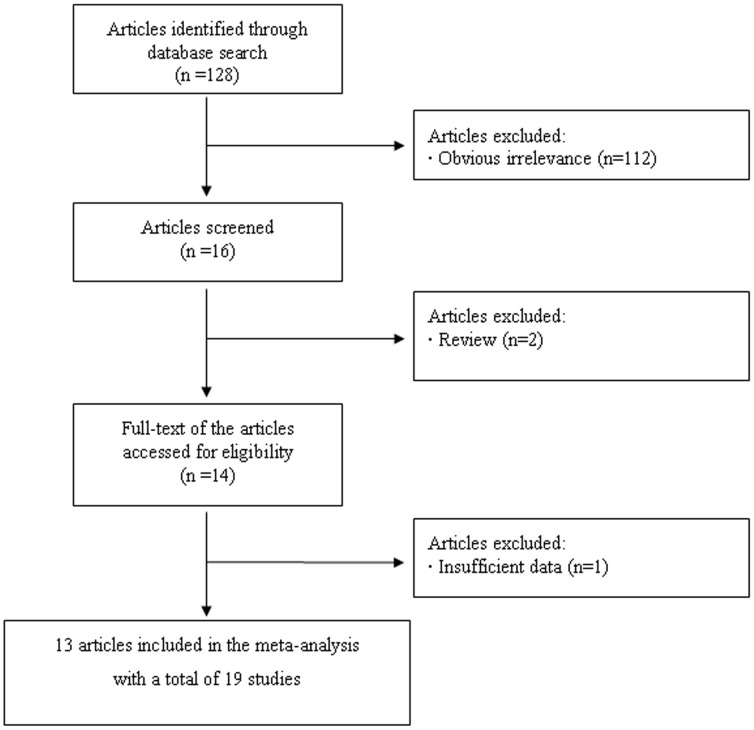
Flow chart of meta-analysis for exclusion/inclusion of individual articles (or studies).